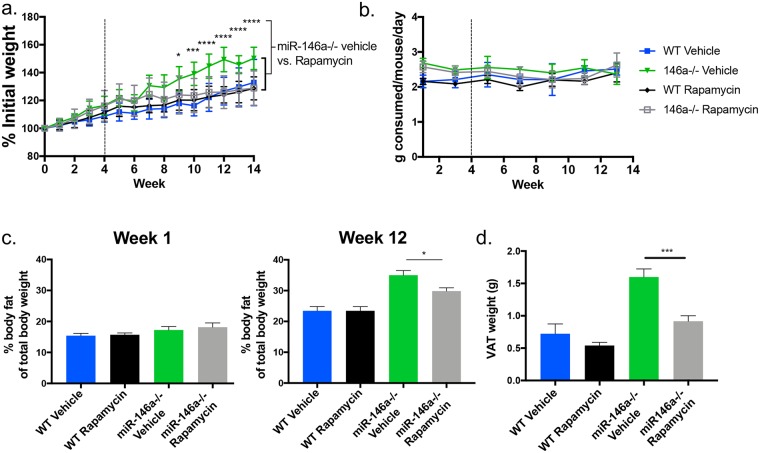
mTOR inhibition reduces the miR-146a HFD phenotype in vivo.(A) C57BL/6 WT and miR-146a-/- mice were placed on HFD for 4 weeks. After 4 weeks, mice were regularly injected with either rapamycin or vehicle control for the duration of the HFD. Shown is the measure of percent weight over time, based on initial weight. Significance levels are indicated for miR-146a-/- vehicle vs. rapamycin groups. (B) Amount of chow consumed per mouse per day over time of diet. (C) % fat of total body mass at week 1 and week 12 HFD. (D) Weight of WT and miR-146a-/- VAT after 14 weeks of HFD in rapamycin or vehicle groups (n = 8/group). p-values for (A) were calculated using RM-ANOVA, corrected for multiple comparisons using Tukey. p-values for (C-D) were calculated using a two-tailed Student’s t-test *p<0.05; **p<0.01; ***p<0.001; ****p<0.0001.